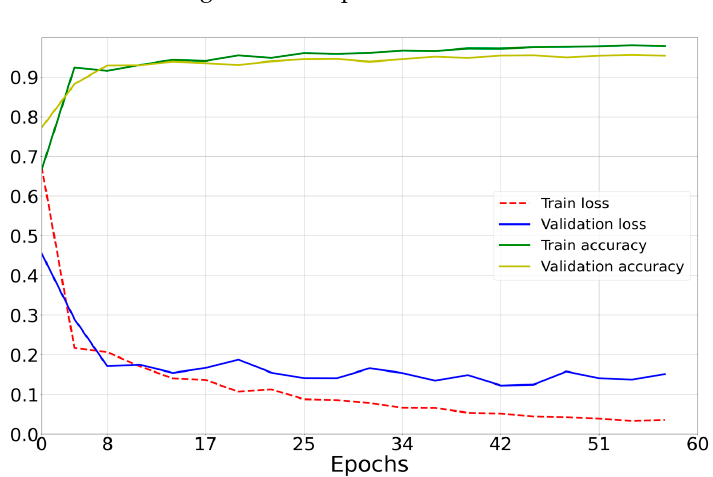
Figure 11. Loss curves of the model in Figure 9b (green and yellow) and accuracy curves (blue and red).